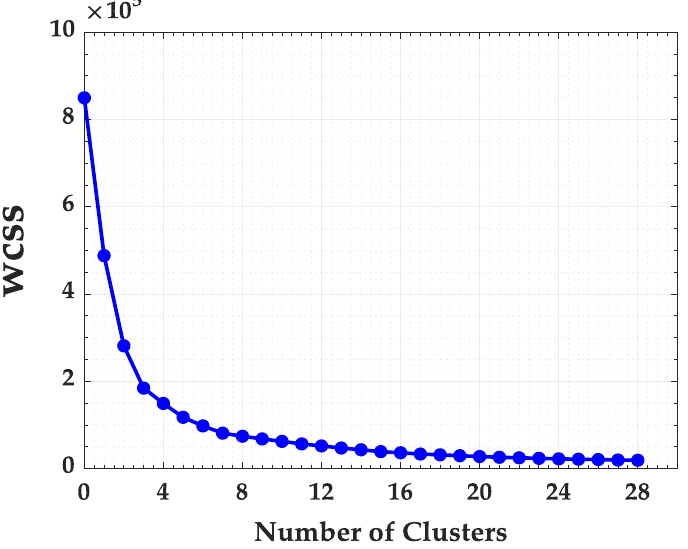
Figure 8. Within Cluster Sum of Squares (WCSS) for Pará State.